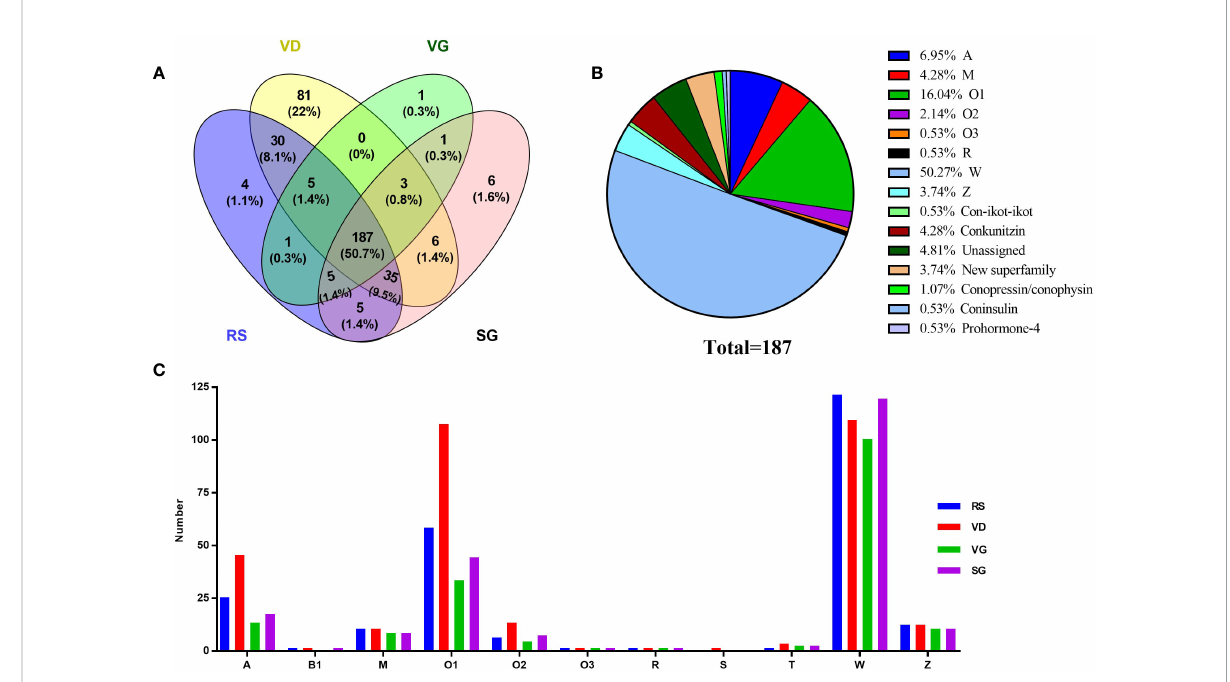
FIGURE 2 Comparison of conotoxin transcripts from various C striatus datasets. (A) Relationship of the identi fi ed conotoxins from the RS, VD, VB, and SG datasets. (B) Total common conotoxins from the four organs. (C) Total superfamilies identi fi ed in the RS, VD, VB, and SG,